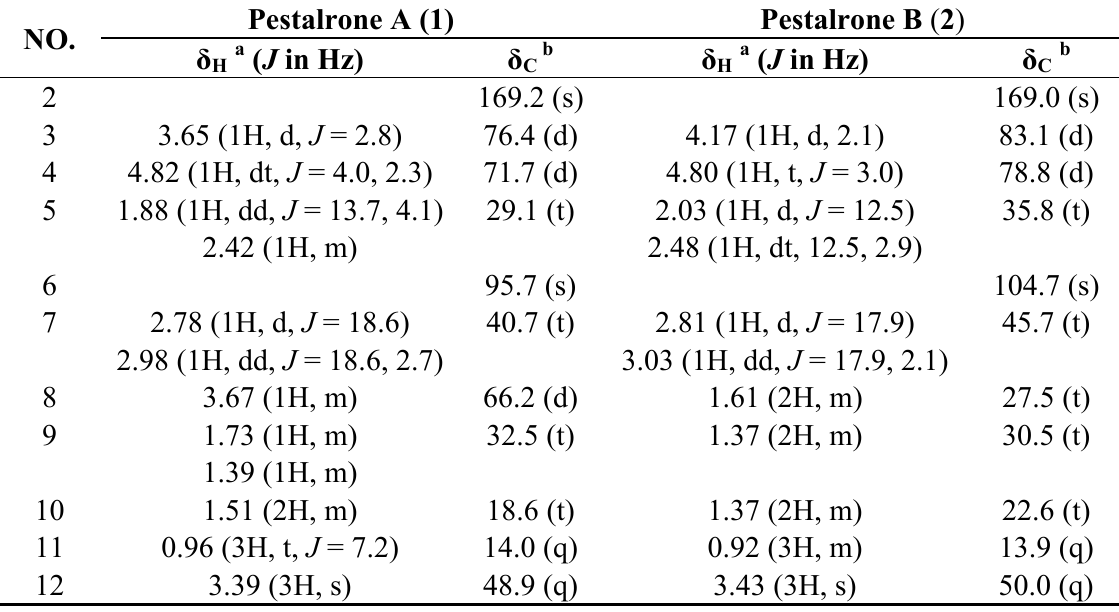
Table 1. NMR spectroscopic data of pestalrone A ( 1 ) and pestalrone B ( 2 ) in chloroform- d